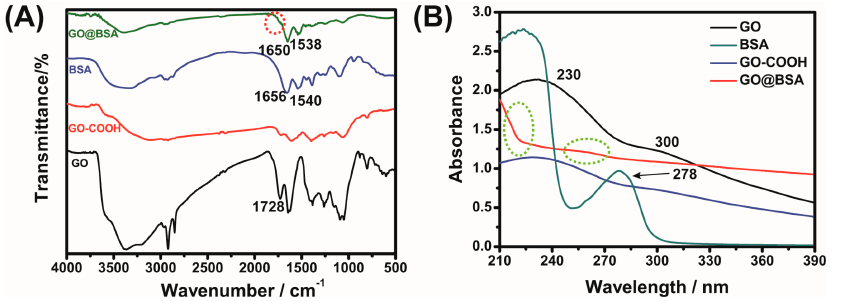
Figure 2. Fourier Transform infrared spectroscopy (FTIR) ( A ) and UV-vis ( B ) spectroscopy of GO, GO–COOH, BSA,